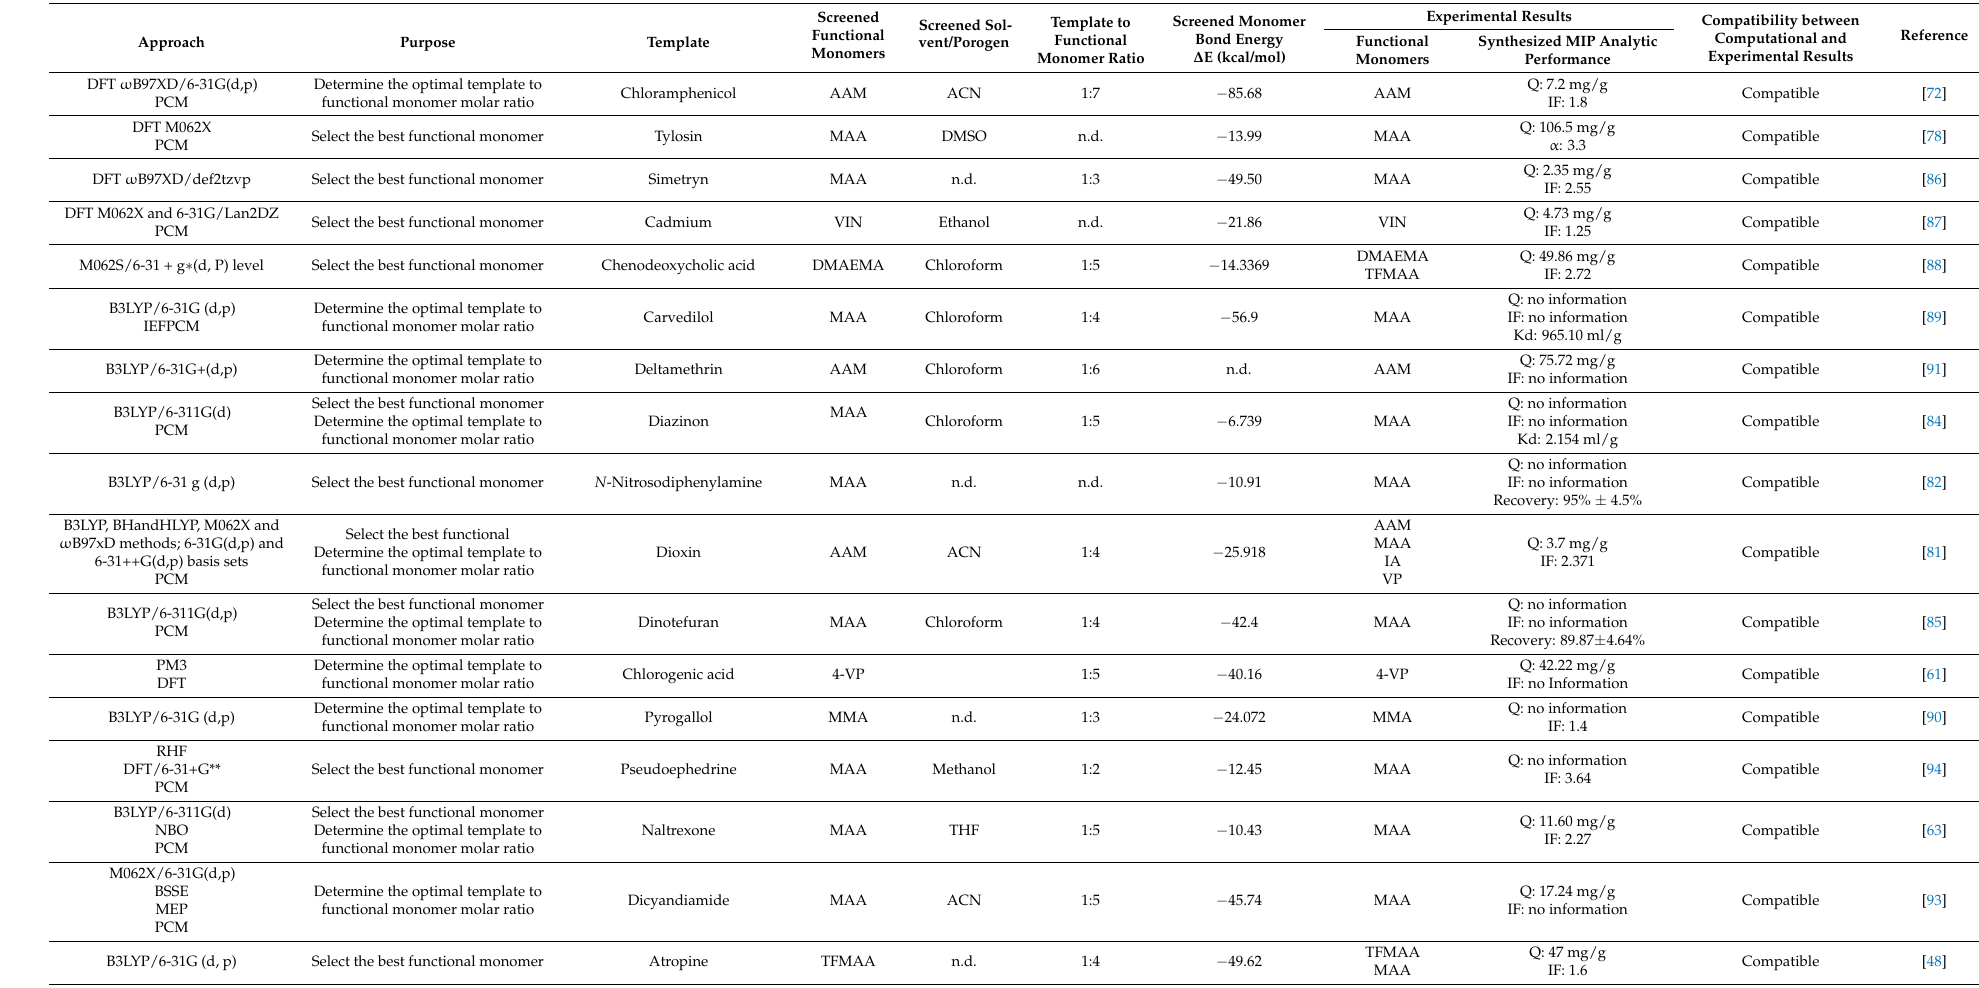
B3LYP/6-31G(d,p) Selectthebestfunctionalmonomer Atropine TFMAA n.d. 1:4 − 49.62 TFMAA MAA Q:47mg/g IF:1.6 Compatible [48] Abbreviations: B3LYP, Becke 3 lee Yan Par; AAM, acrylamide; THF, tetrahydrofuran; ACN, acetonitrile; α , selectivity coefficient; Q, adsorption capacity; IF, imprinting factor; VIN, 1-vinylimidazole; DMAEMA, 2-(dimethylamino)ethyl methacrylate; AA, acrylic acid; IEFPCM, the integral equation formalism polarizable continuum model; Kd, distribution coefficient; HIMA, 2-hydroxy-3-(isopropylamino)propyl methacrylate; MMA, methyl methacrylate; THF, tetrahydrofuran; NBO, natural bond orbital, BSSE, basis set superposition error; MEP, molecular electrostatic potential; n.d., not